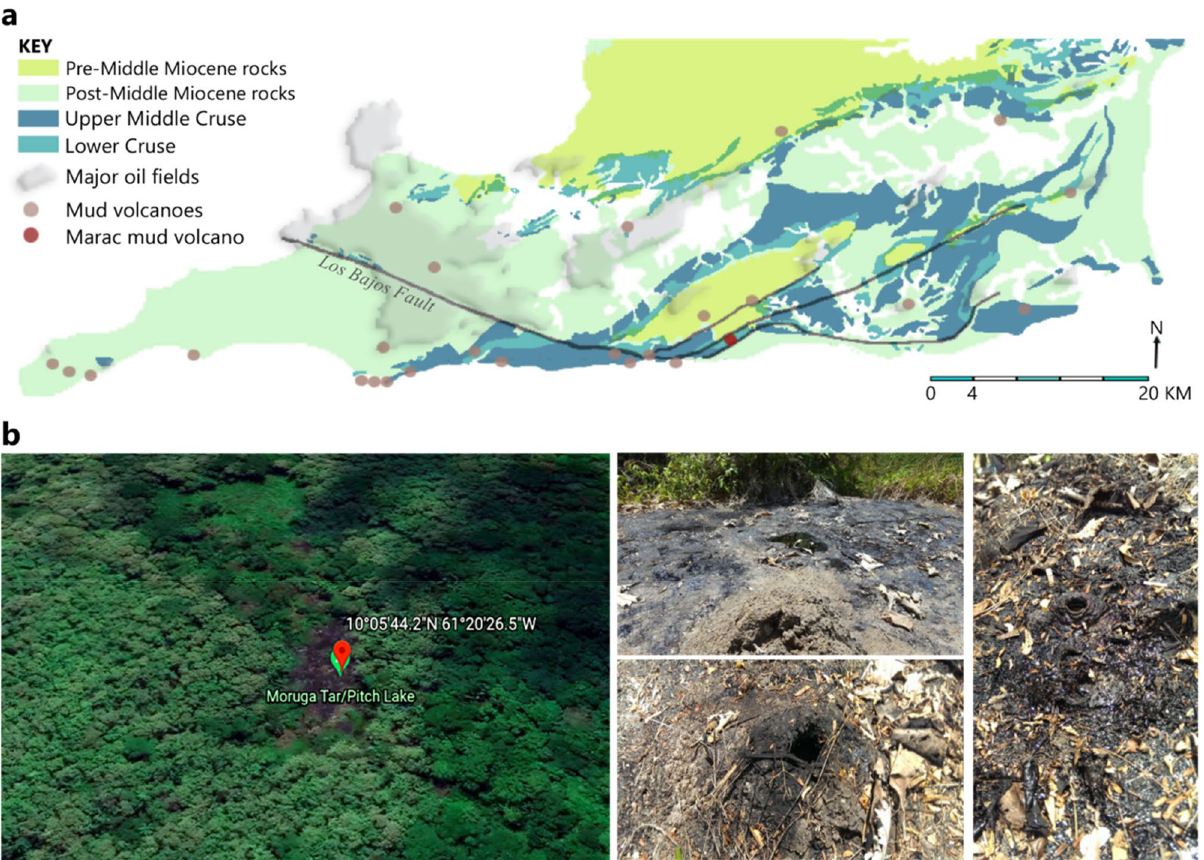
Figure 5. Mud volcanoes (MVs) in Southern Trinidad. ( a ) Location of Marac in Southern Trinidad. Stratigraphically, Marac is located in the Miocene-aged Cruse and Karamat Formation. Geological formations are redrawn from Archie 123 , Vincent 124 and Soto et al . 125 . (Adobe Photoshop 2021; 22.3.1 Release;